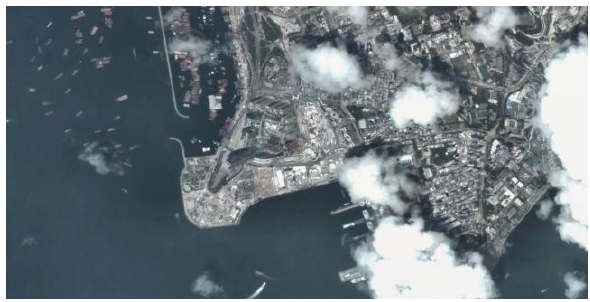
Figure 3. Sample frame in Jilin-1 satellite videos.